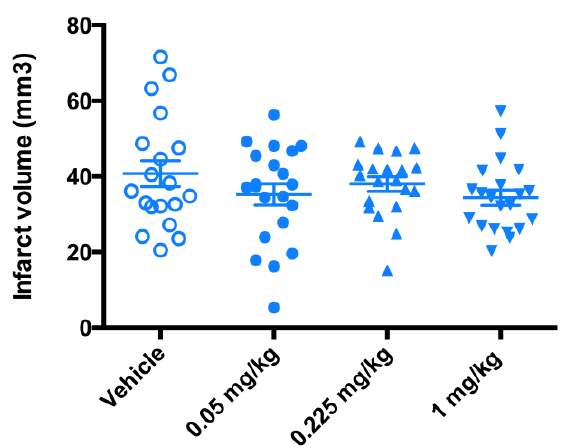
Figure 8. Evaluation of the infarct volume in a 3-day mouse MCAO stroke model. Mice ( n = 20) underwent a 90-min occlusion. FeHex was given IV via the tail vein at three different doses starting at 90 min post reperfusion and continued twice daily for 3 days as indicated in the plot. No significant change in the infarct volume relative to the vehicle was found with either concentration. FeHex 0.225 mg / kg vs. Vehicle, p = 0.48.